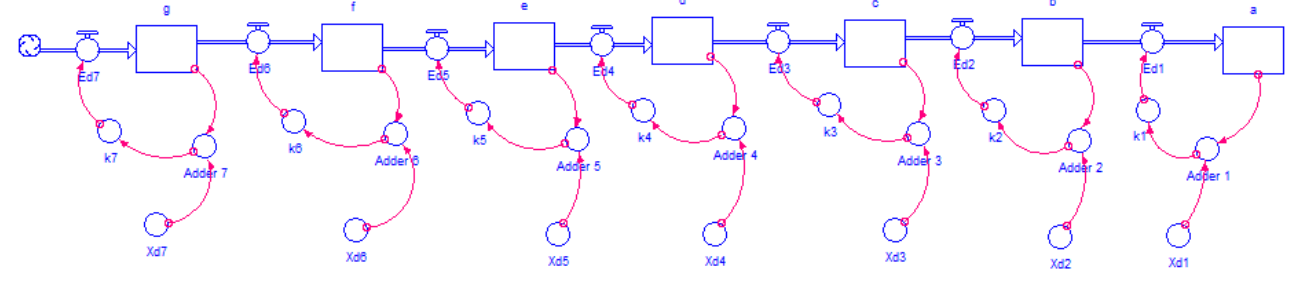
Figure 3. Forrester diagram of the textile process.